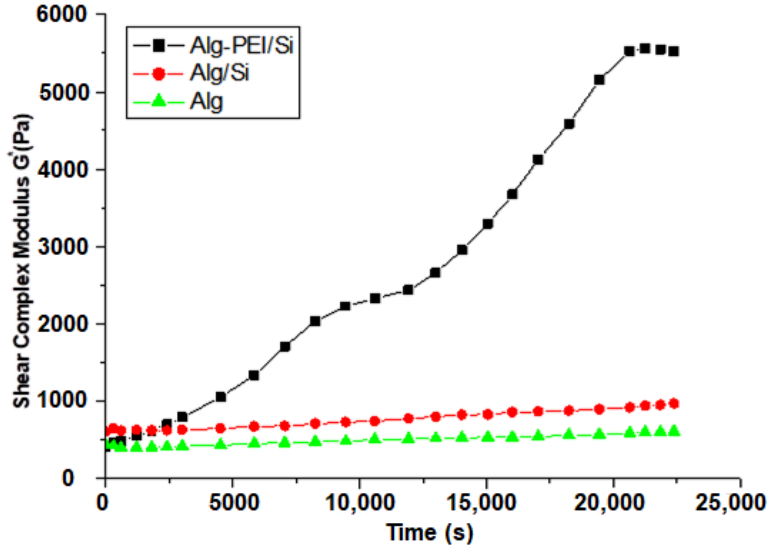
Figure 1. Complexation and gelation kinetics of the biomaterials (Alg, AlgSi, and Alg-PEI/Si), with each data point representing the mean ( n = 3). Table 1. The comparison of Young’s modulus of the three different printed scaffolds. Bio-Inks Solidification Solution Young’s Modulus Alg-PEI/Si 3D biomaterial scaffold Alg-PEI/HAP 3D biomaterial